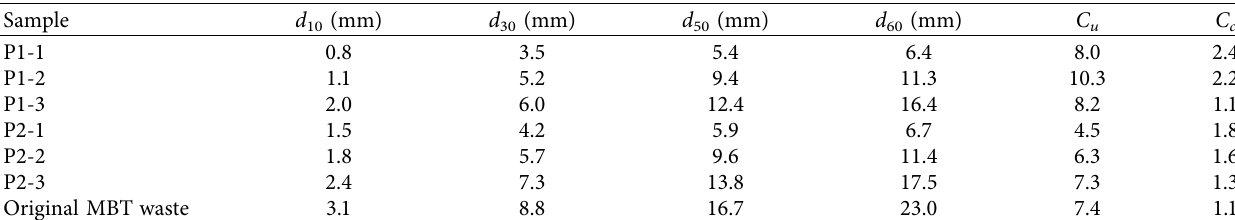
Figure 4: Grain size distribution curves of samples with different particle Table 2: Results of particle size, uniformity coefficient, and curvature coefficient of MBT waste.